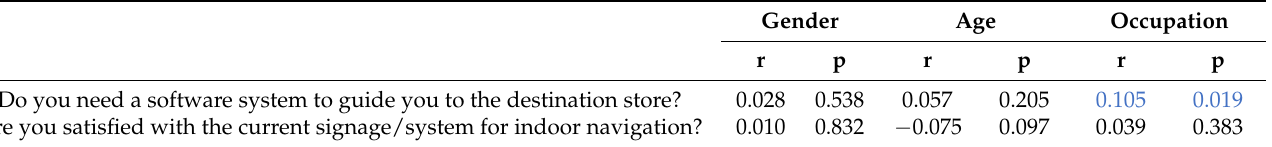
Table 9. Correlation analysis between characteristics (personal basic information) and demand variables (subjective data) 1